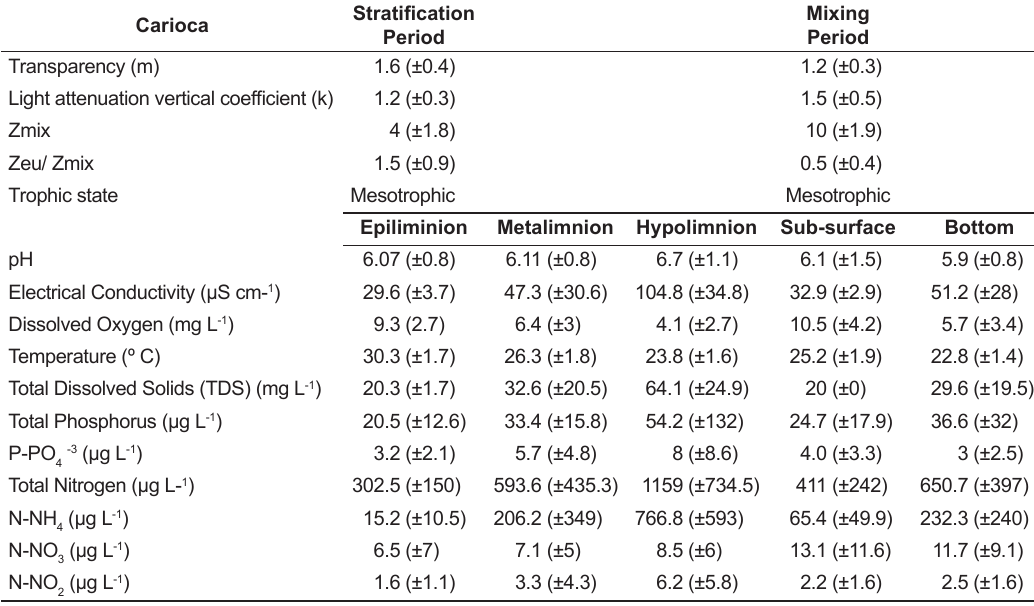
Table 1. Water physical and chemical variables (averages and standard deviations of the five years of Lake Carioca, Rio Doce State Park, Minas Gerais State, southeast Brazil.